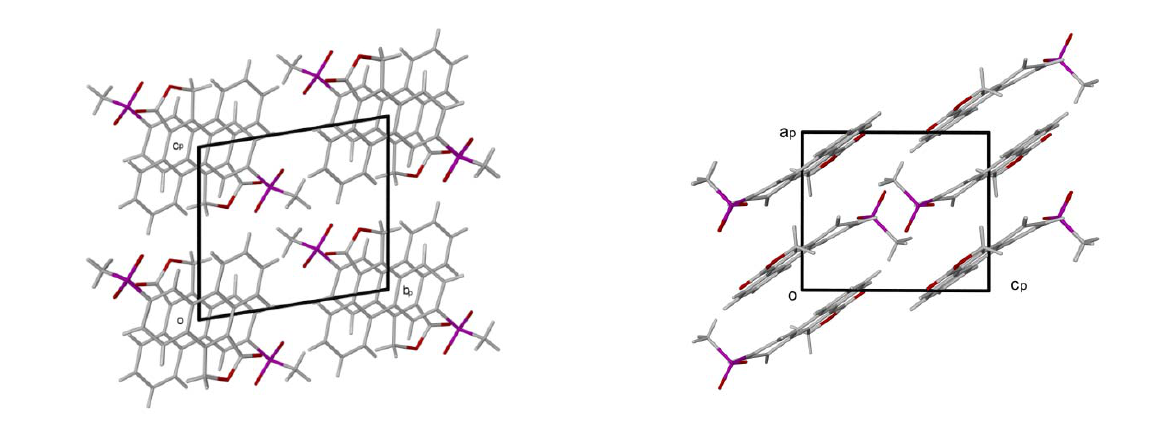
Figure 6. Packing diagrams of I down the a -axis and b -axis